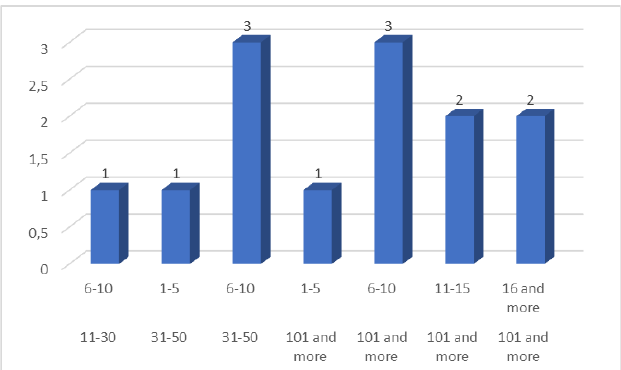
Fig. 2. Number of employees in project teams in the surveyed companies .